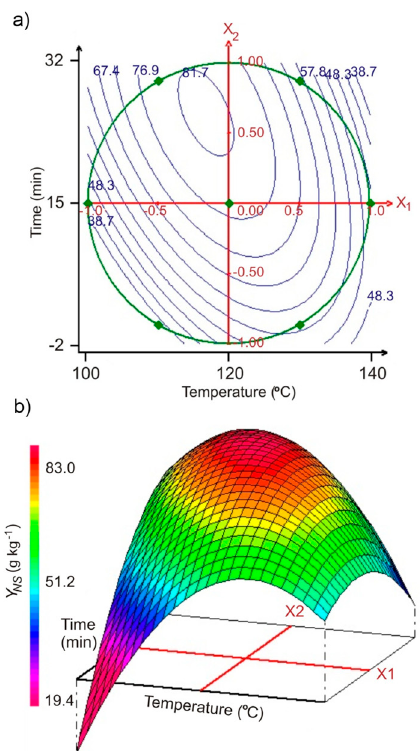
Figure 3. ( a ) Contour plots of the sum of neutral monosaccharides yield Y NS versus hydrolysis temperature and time of SBP hydrothermal treatment (representations based on the quadratic polynomial model, Equation (2); results obtained from Doehlert matrix, Table 2); ( b ) corresponding three-dimensional plot.